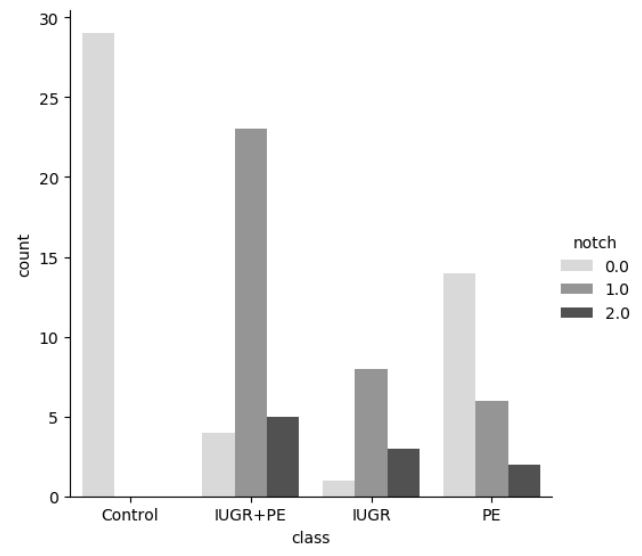
Figure 5. Distribution of notch feature by class: 2.0 means that both arteries have a notch, 1.0 that an artery has a notch (right or left), and 0.0 that no notch has been